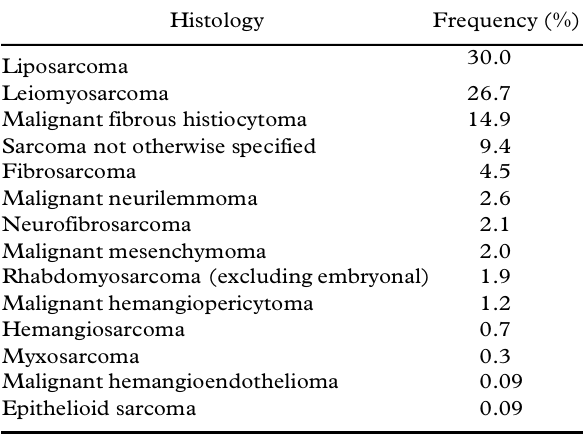
Table 2. Frequency of histological subtypes of retroperitoneal sarcoma